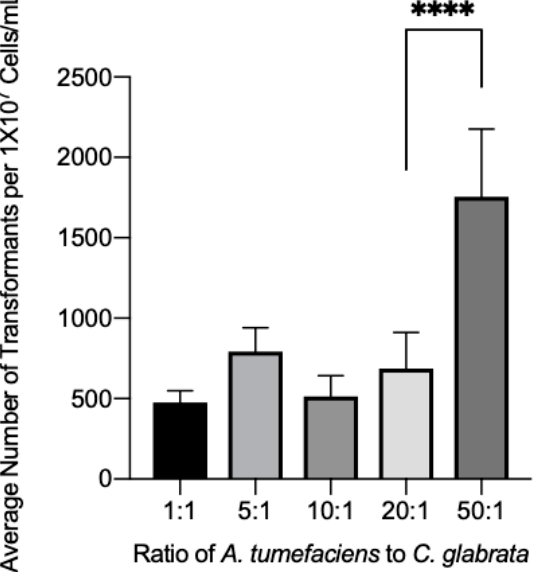
Figure 4. The effect of agar concentration in co-culture media on transformation efficiency. Wild-type C. glabrata and A. tumefaciens were mixed onto nitrocellulose membranes and plated onto co-culture media with different percentages of agar. Brackets with **** or *** above bars indicate groups with statistically significant differences. *** = p ≤ 0.001, **** = p ≤ 0.0001.